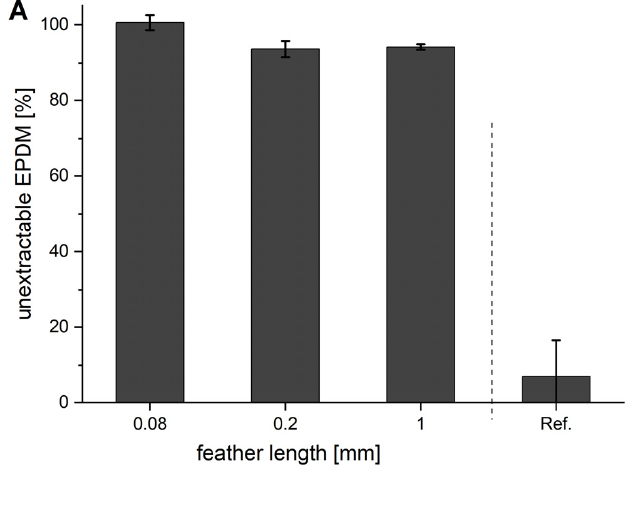
Figure 8. ( A ) Amount of non-extractable material after 72 h of Soxhlet extraction with toluene. Samples were prepared with 100 phr of feathers in three lengths using the EPDM mixture M2 without sulphur. A vulcanised M2 mixture without feathers and sulphur is used as reference. ( B ) Schematic illustration of the cross-linking of EPDM rubber with keratin.